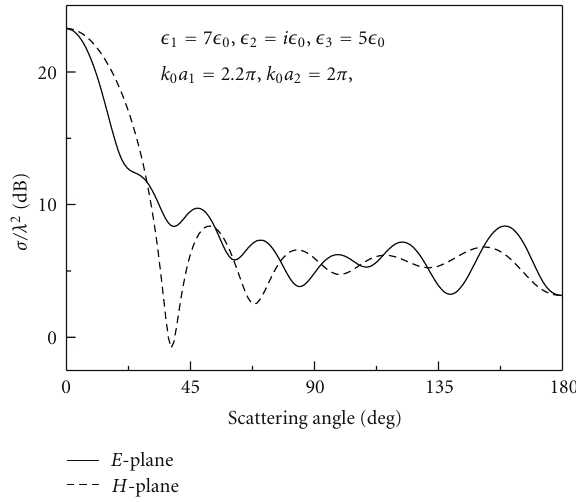
Figure 3: Radar cross-sections (RCSs) versus scattering angle θ (in degrees) in the E -plane (solid curve) and in the H -plane (dashed curve). The electric dimensions of the outer and inner spherical surfaces are chosen as k 0 a 1 = 2 . 2 π and k 0 a 2 = 2 π while the per- mittivity tensor elements of the plasma are assumed to be (cid:2) 1 = 7 (cid:2) 0 , (cid:2) = i (cid:2) (cid:2) = 5 (cid:2) 2 0 , and 3 0 , respectively.